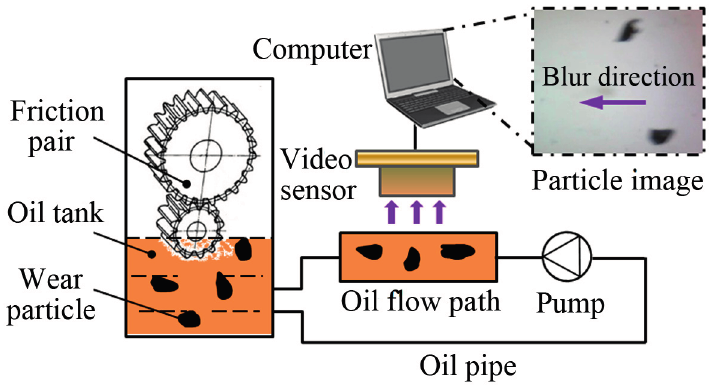
Figure 1. Schematic diagram of dynamic wear debris imaging system.